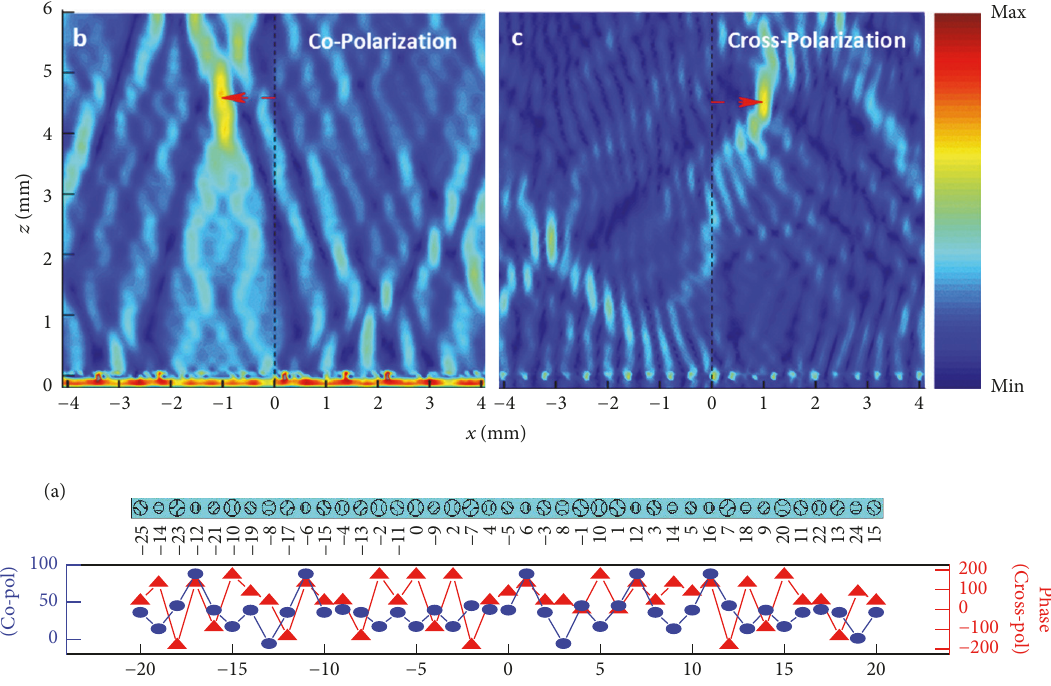
Figure 4: (a) The structure of SOPFM and its phase distributions at 0.68 THz. (b, c) The electric field intensity distribution of copolarized and cross-polarized transmitted wave, respectively.